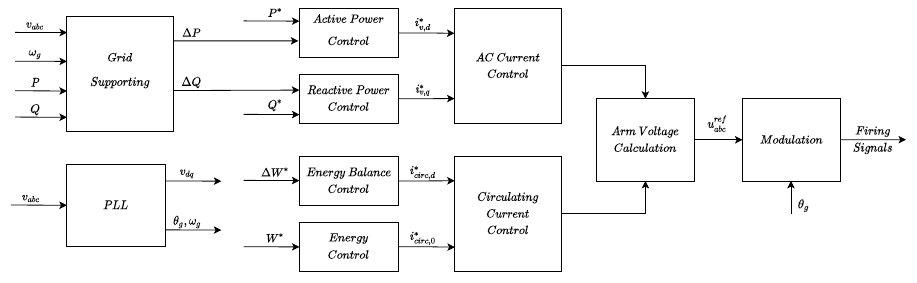
Figure 3. Block diagram of an MMC-based GFL converter embedded with supporting